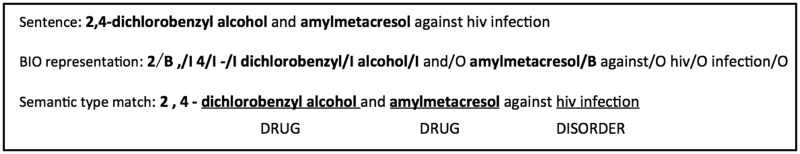
An example of semantic type annotation for context feature extraction.